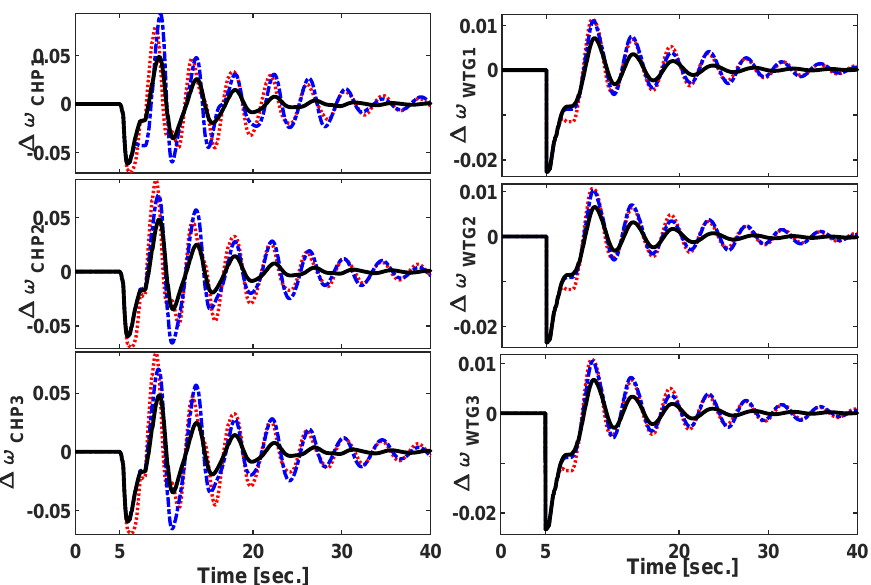
Figure 18. The oscillations of the angular velocity of generation units in scenario 2; black(solid): RL-PID, blue (dashed–dotted): F-PID, red (dotted): PID.